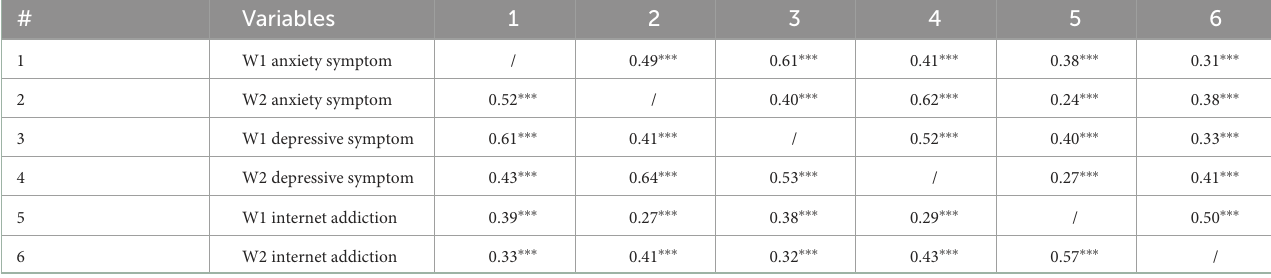
TABLE 2 Inter-correlations between Internet addiction, depressive and anxiety symptoms ( n = 7,958). #